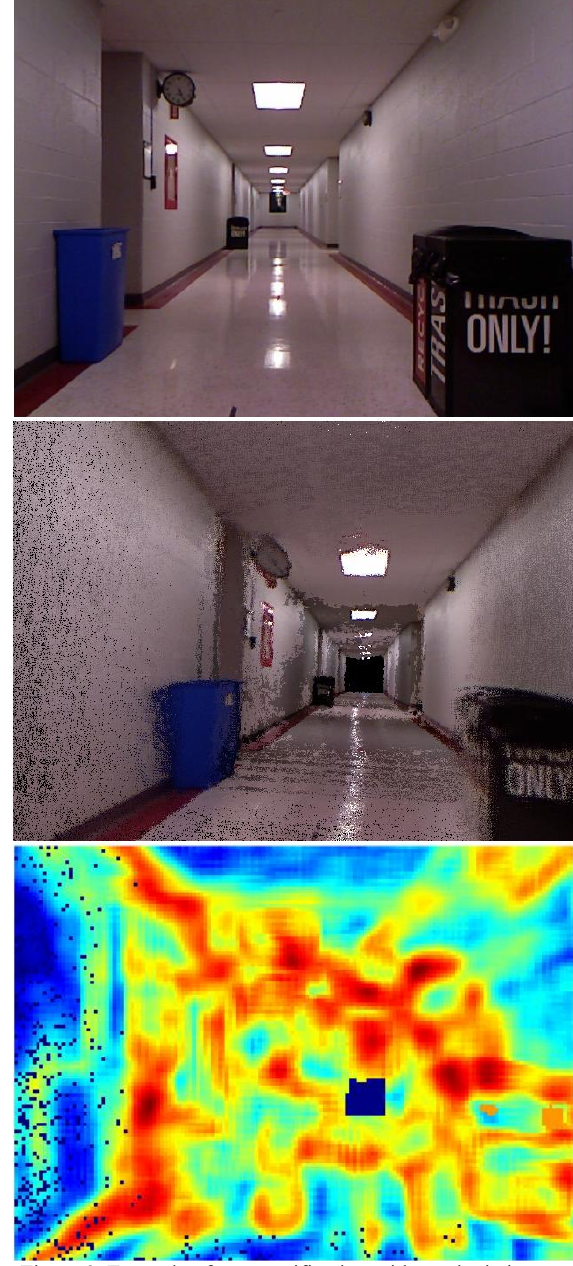
Figure 9. Example of pose verification with synthetic image (2nd row) on Group 1 data (1st row) and error